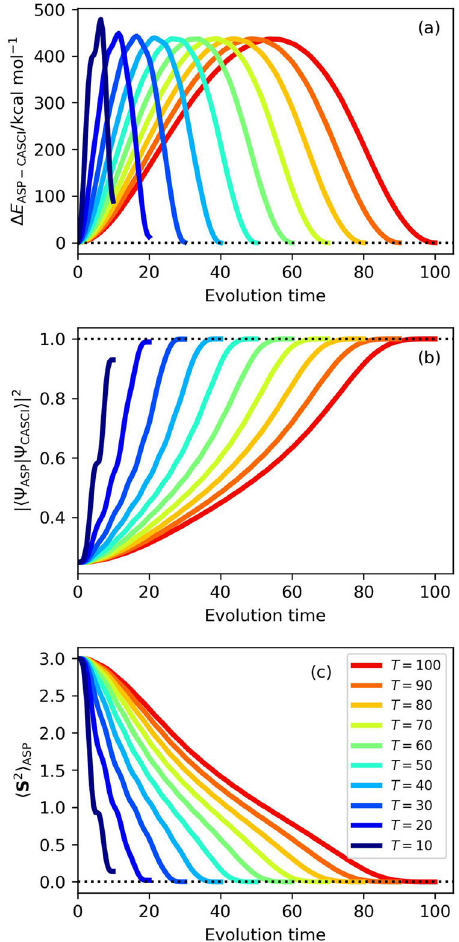
Fig. 6 Results of the numerical simulation of ASP with | Ψ BS 〉 as the starting wave function and square function as the scheduling function in N 2 molecule at R(N – N) = 3.0 Å. a The energy deviations from the CASCI values. b The square overlaps with the CASCI wave functions. c The 〈 S 2 〉